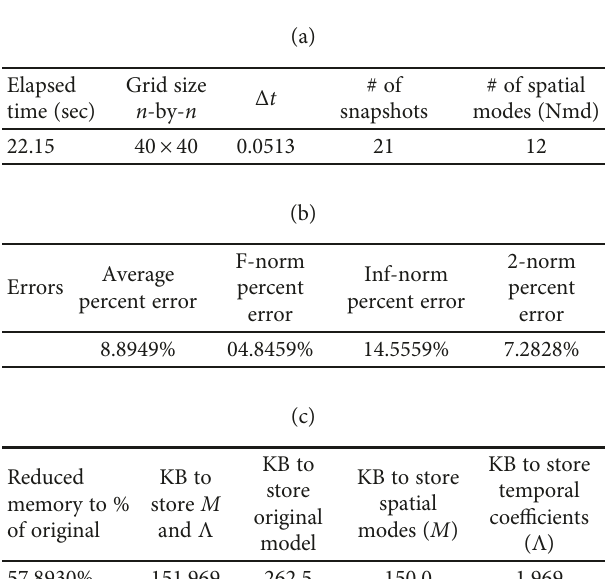
Table 3: Algorithm 3 results (40 × 40 grid, N = 21, N